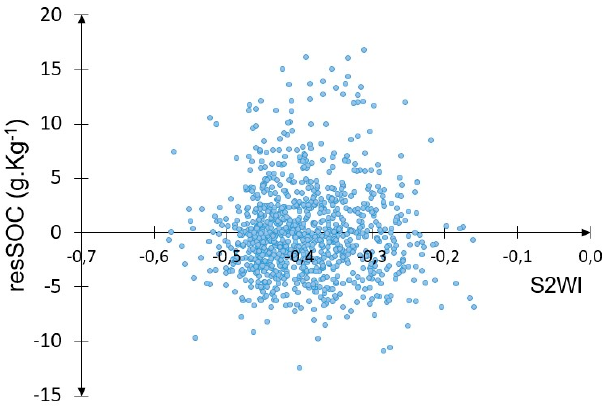
Figure 10. Plot of residuals of SOC prediction (resSOC) against S2WI for all dates.